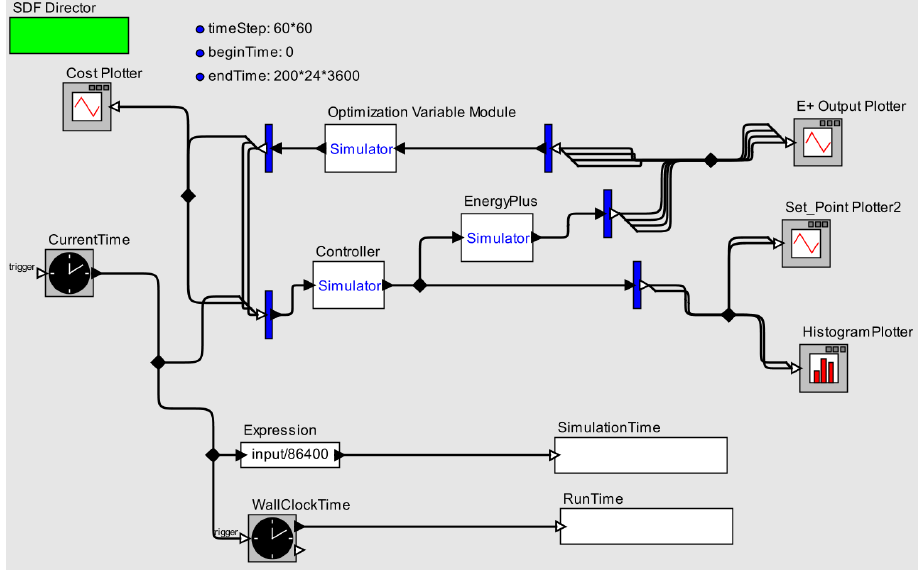
Figure 2. An overview of the BCVTB building simulation setup. It shows three modules (optimization variable, EnergyPlus and controller) alongside various ancillary plotting, time-keeping functionalities. In the figure, blue bars are for splitting output vector streams into multi-line data streams for plotting and data saving uses.